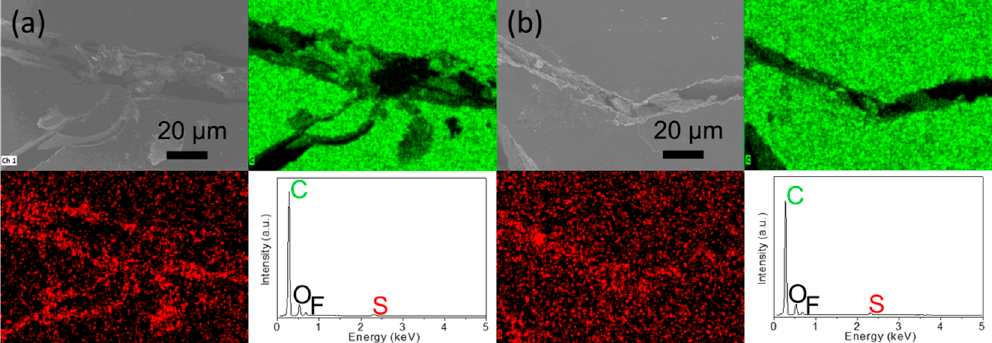
Figure 4. Electrochemical analysis: microstructural inspection and elemental mapping results of the inserted carbon paper for the polysulfide diffusion analysis: ( a ) the side facing cathode and ( b ) the side facing anode.